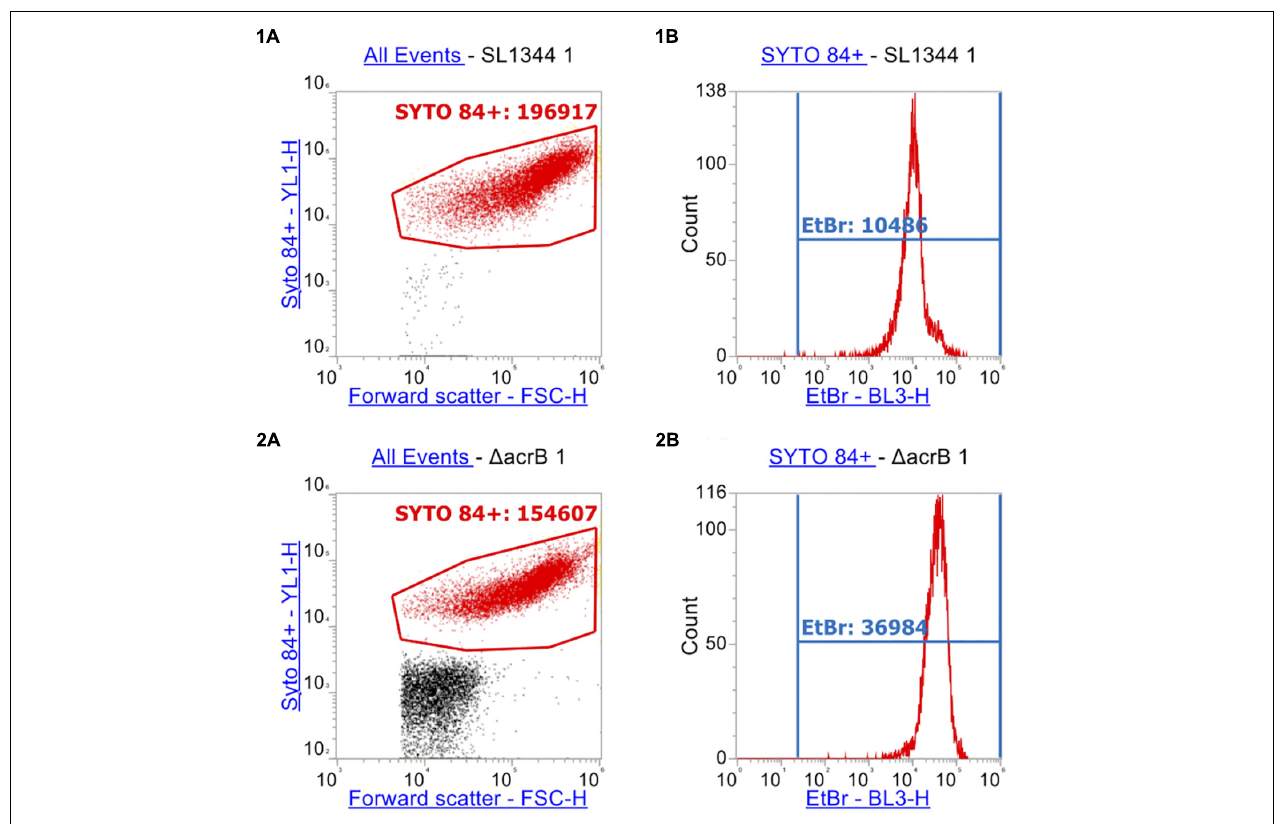
FIGURE 4 | Flow cytometry plots of SL1344 and SL1344 (cid:49) acrB . (1) shows plots of SL1344 and (2) shows plots of efflux mutant SL1344 (cid:49) acrB. (A) Separation of cells from background cell debris using channels YL1-H vs. FSC-H. SYTO 84 + cells are gated (red gate) with the X-median value given. 10,000 events were collected inside the SYTO 84 + gate. From this, the red population is analyzed in (B) plots where the BL3-H channel was used to measure the X-median of ethidium bromide fluorescence in a new gate (EtBr in Blue). Fluorescence of ethidium bromide was only measured from the SYTO 84 + population.